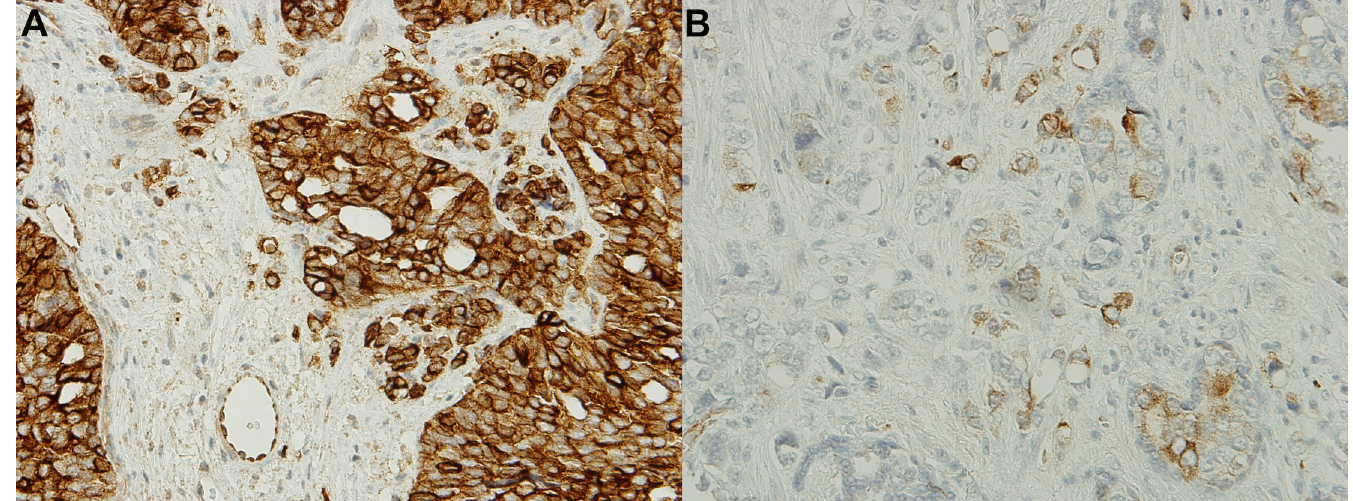
Fig 1. Expression of class III β -tubulin ( β III-tubulin) in available tissue samples (400x magnification). Tissue obtained via biopsy or surgery of the primary tumor was analyzed for the presence of β III-tubulin by immunostaining. (A) Tissue with a high expression of β III-tubulin (staining intensity 2+ or 3+). (B) Tissue with a low expression of β III-tubulin (staining intensity 0 or 1+).